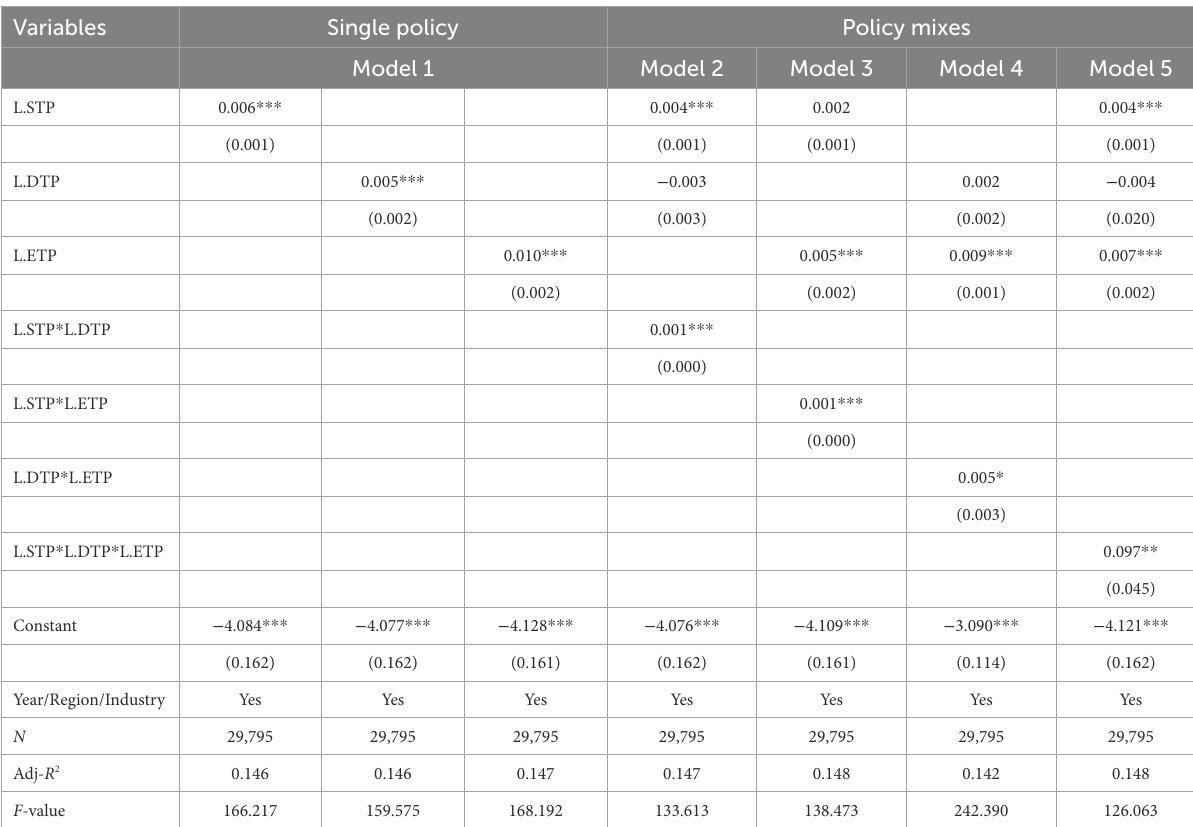
TABLE 8 Estimation for lagging one-period talent policies and their mixes.